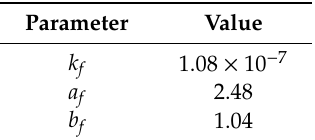
Figure 16. Low-frequency noise spectrum measurements of the set-up, shown in Figure 13, and simulations using the model in Figure 15. Table 5. Low-frequency noise